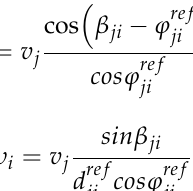
Figure 7. Following form of ( , ) . d ref ∈ ( 0, + ∞ ) and ϕ ref ∈